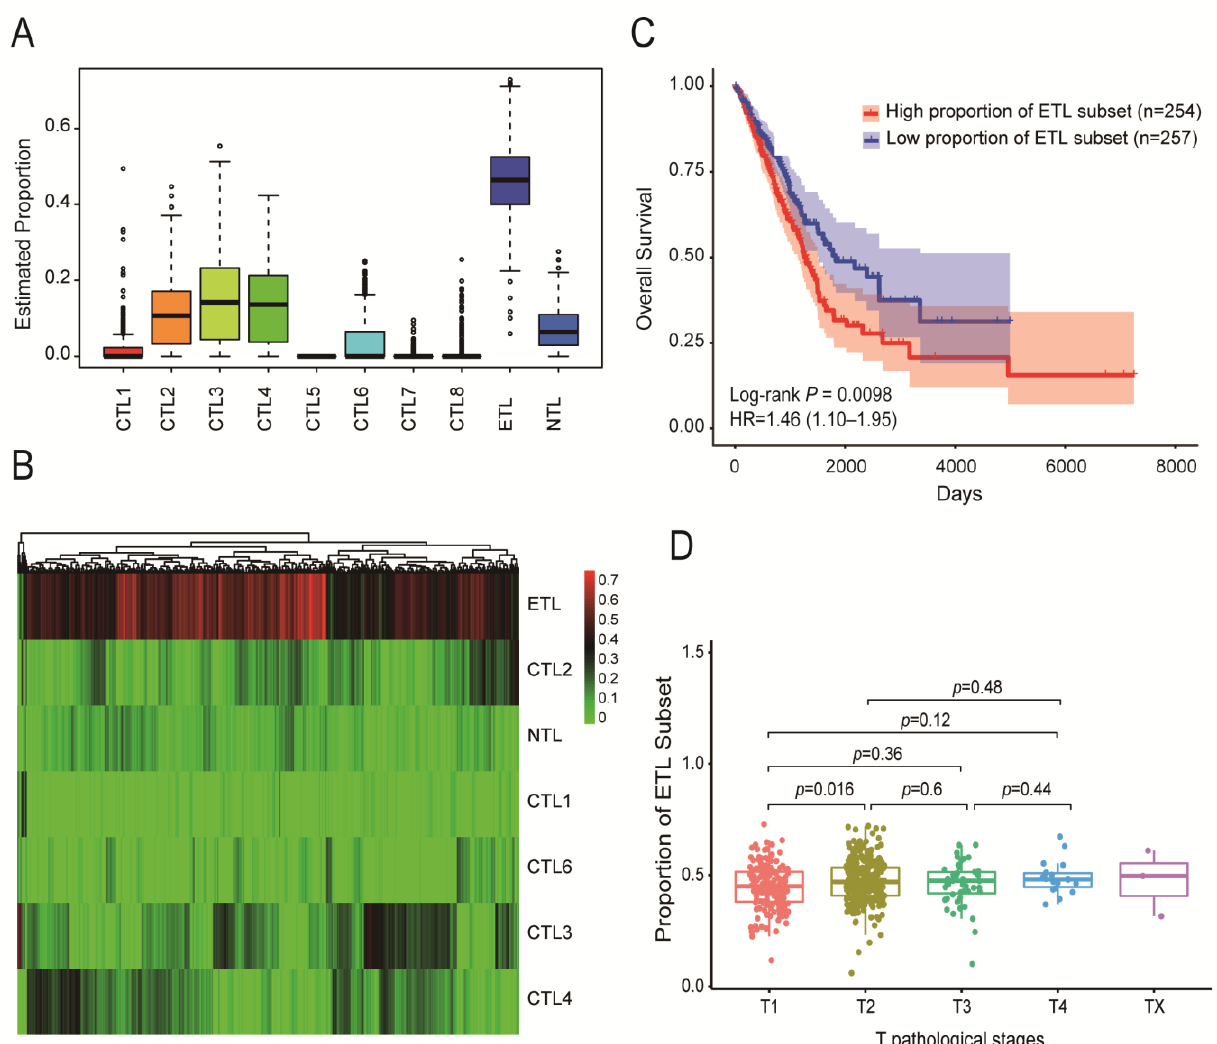
Figure 2. Distribution of ten CD8+ T cell subsets in TCGA-LUAD samples and their impact on patient prognosis. ( A ) Proportion of ten CD8+ T cell subsets among immune cells in TCGA-LUAD samples. ( B ) Heatmap of the distribution of ten CD8+ T cell subsets in TCGA-LUAD samples. ( C ) The effect of ETL subset proportion on the OS of LUAD patients: the higher the proportion of the ETL subset, the shorter the OS of LUAD patients. ( D ) Distribution of ETL subset in different T stages of LUAD patients: the larger the proportion of the ETL subset, the higher the T